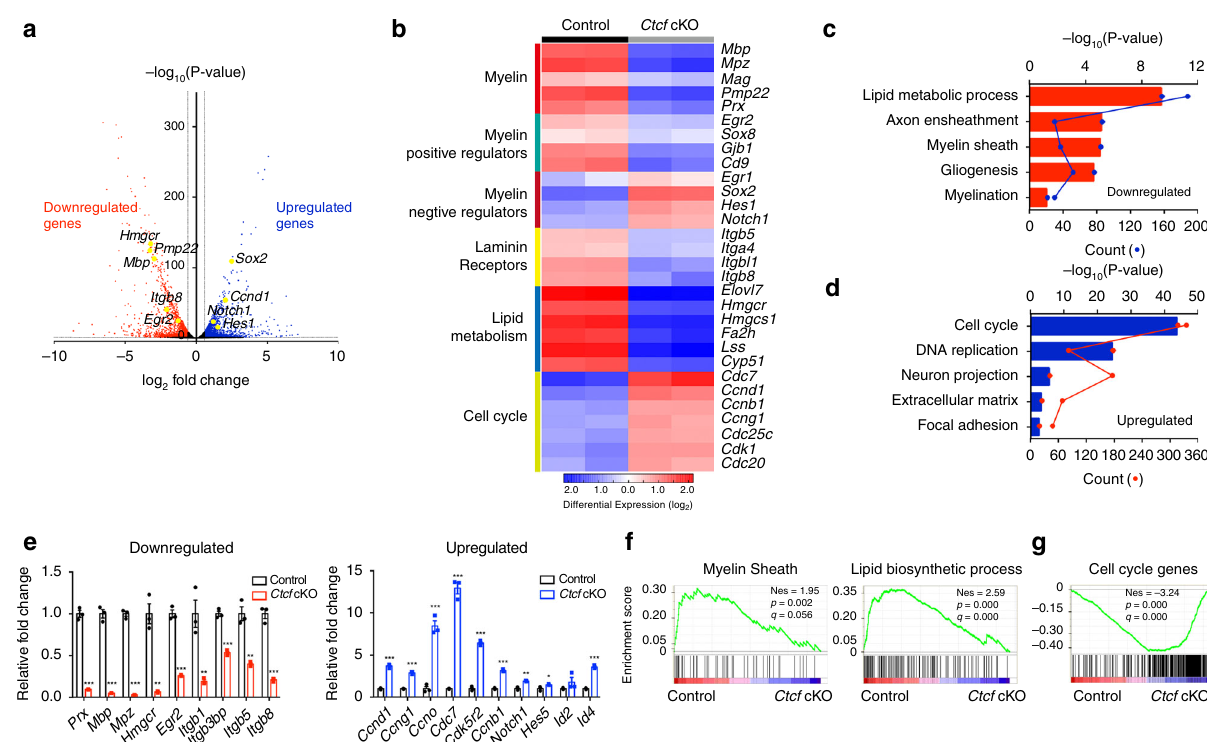
Fig. 6 CTCF regulates the transcriptional program of SC differentiation. a Volcano plot of transcriptome pro fi les of control and Ctcf cKO sciatic nerves ( n = 2 animals/genotype). Red and blue dots represent signi fi cantly downregulated and upregulated genes in Ctcf cKO nerves compared to the control, respectively ( P < 0.05, fold-change > 1.5). b Heatmap of representative genes and their categories differentially expressed in control and Ctcf cKO sciatic nerves ( n = 2 animals/genotype). c , d Bar plots of gene ontology analysis of genes c downregulated and d upregulated genes in Ctcf cKO sciatic nerves compared with control nerves. Each dot (connected by lines) represents the gene count of the corresponding biological function categories. n = 2 independent tissues/genotype. e qPCR analysis of genes related to SC development that are decreased (left) and increased (right) in Ctcf cKO sciatic nerves relative to control. f GSEA enrichment scores for myelin sheath (left) and lipid biosynthetic process (right) gene sets in control and Ctcf cKO sciatic nerves. g GSEA enrichment scores for cell-cycle gene sets in control and Ctcf cKO sciatic nerves. Data are presented as means ± SEM., *** P < 0.001, ** P < 0.01, * P < 0.05, n = 3 animals/genotype; two-tailed unpaired Student ’ s t -test, P (Prx) = 2.6e-05, P (Mbp) = 4.9E-05, P (Mpz) = 5.3E-06, P (Hmgcr) = 0.0014, P (Egr2) = 8.6E-05, P (Itgb1) = 0.008, P (Itgb3bp) = 0.00022, P (Itgb5) = 0.0021, P (Itgb8) = 0.00017, P (Ccnd1) = 7.4E-05, P (Ccng1) = 5.1E-05, P (Ccno) = 0.0004, P (Cdc7) = 6.4E-05, P (Cdk5r2) = 1.6E-05, P (Ccnb1) = 3.2E-05, P (Notch1) = 0.00102, P (Hes5) = 0.028, P (Id2) = 0.23, P (Id4) = 3.3E-05. Source data are provided as a Source Data fi